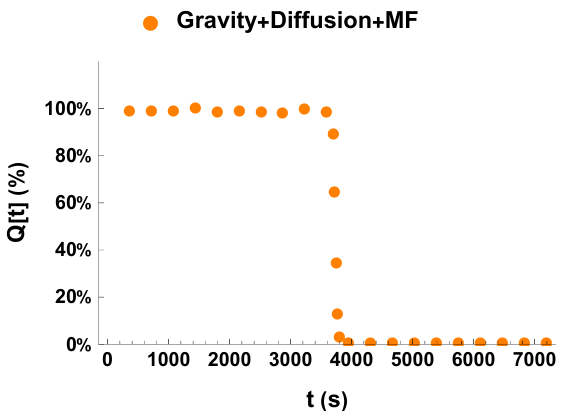
Figure 12. PVP-FeNp aggregates’ survival probability Q ( t ) in mucus. Particles exhibit diffusion and are pulled by gravity and a magnetic